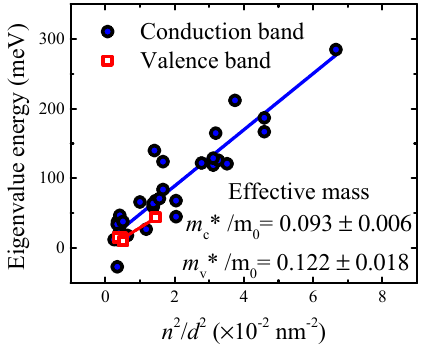
Figure 4. Eigenvalue energy dependence on n 2 / d 2 ratio for conduction and valence bands. The effective mass is evaluated according to Equation (3).